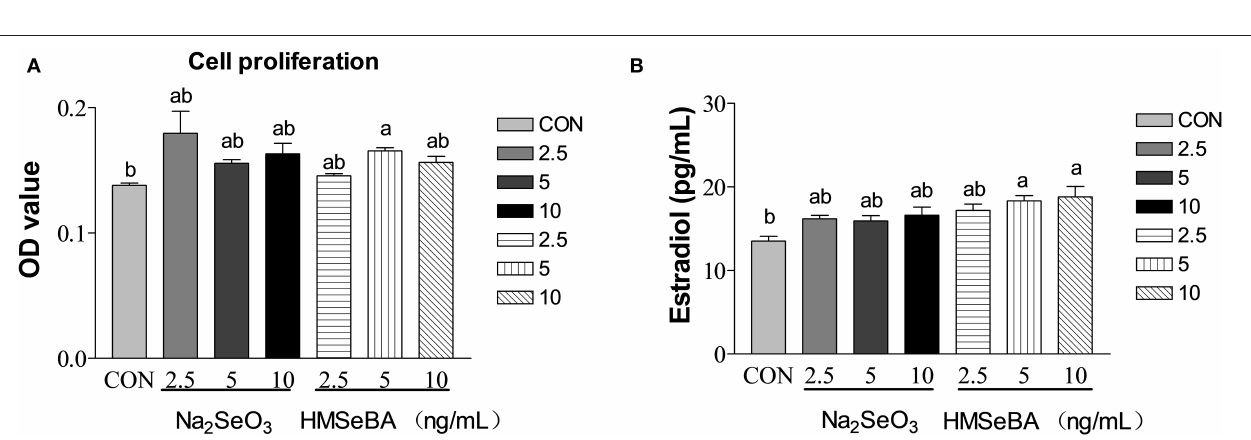
FIGURE 5 | Effects of dietary selenium supplementation on the relative expression of genes related to selenoprotein and antioxidant capacity in the liver and ovary of gilts. (A) Expression of selenoprotein genes in liver of gilt. (B) Expression of antioxidant capacity system related genes in liver of gilt. (C) Expression of selenoprotein genes in ovary of gilt. (D) Expression of antioxidant capacity system related genes in ovary of gilt. Data are expressed as means values and standard error, n = 5. Mean values with different superscript letters were significantly different ( P < 0.05). CON, basal diet; Na 2 SeO 3 , 0.3mg Se/kg Na 2 SeO 3 ; HMSeBA, 0.3mg Se/kg HMSeBA; SELENOP : selenoprotein P; SELENOW : selenoprotein W; SELENOO : selenoprotein O; SELENOH : selenoprotein H; GPX : glutathione peroxidase; TXNRD : thioredoxin reductase; SPS2 : Selenophosphate synthetase 2; SOD : superoxide dismutase; CAT : catalase; GR : Glutathione reductase; SCLY : Selenocysteine lyase; TXN1 : Thioredoxin l.